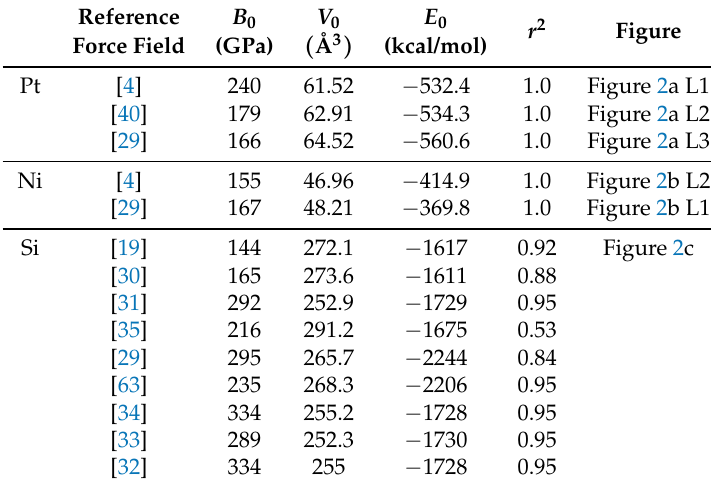
Table A1. Results of BM-eos fitting to different